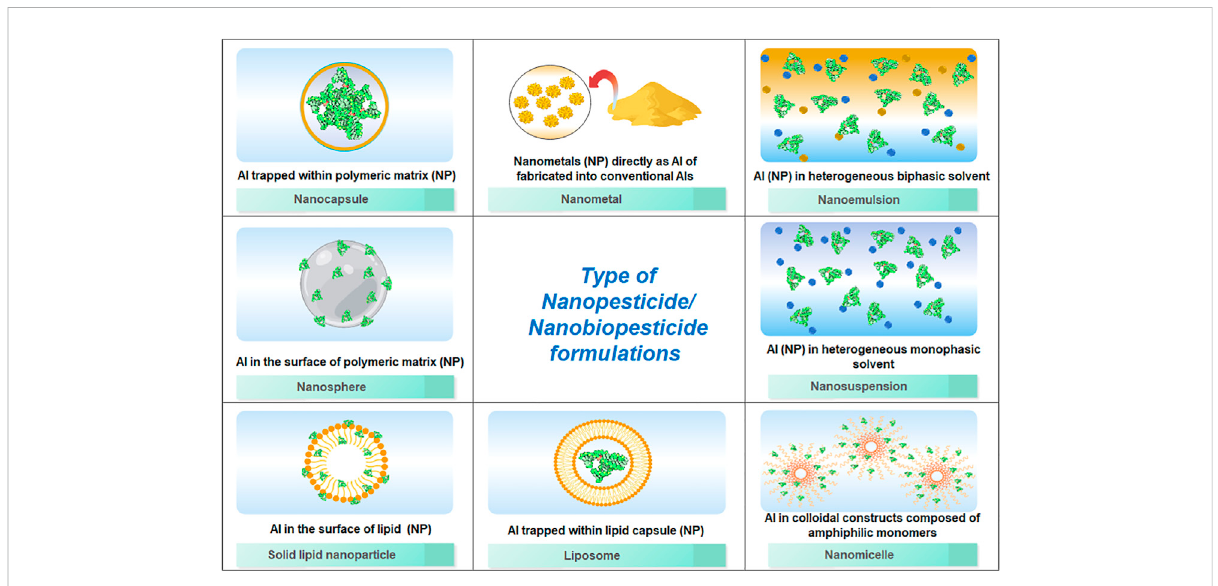
FIGURE 1 Illustration on different ways of nanopesticide formulations (active ingredients with carrier molecule and/or